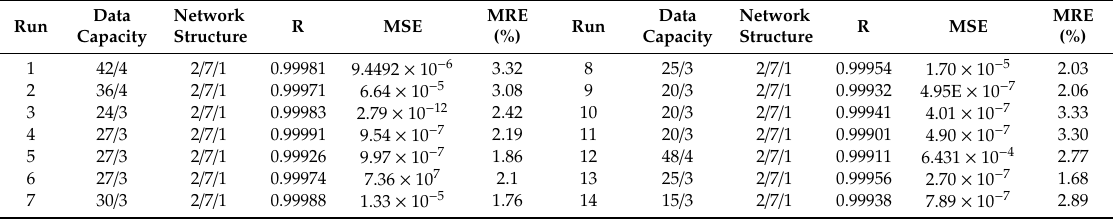
Table 5. The prediction results of BPNN model based on K / S value and dye-uptake data.